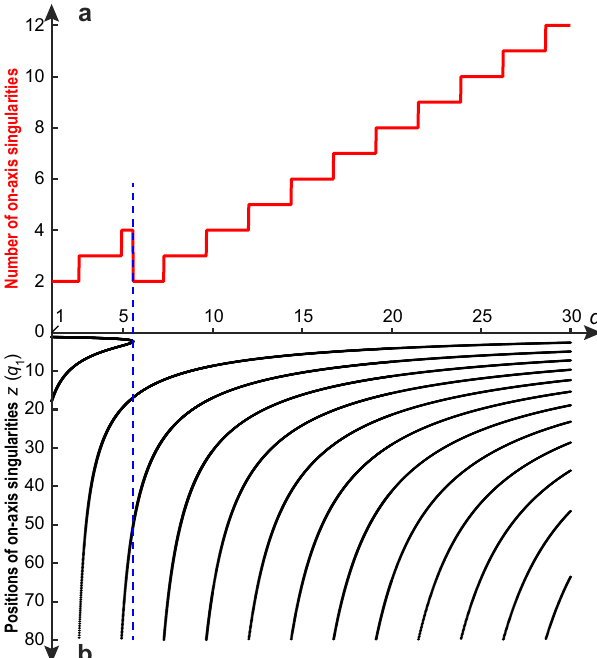
Fig. 6 Evolution of on-axis singularity distribution versus supertoroidal order. a , b The numbers ( a ) and positions ( b ) of on-axis saddle- singularities of the magnetic fi eld of the STLP ( q 2 = 20 q 1 ) within the range of z ∈ [0, 80 q 1 ], versus α . The blue dashed line marks where the number of singularities